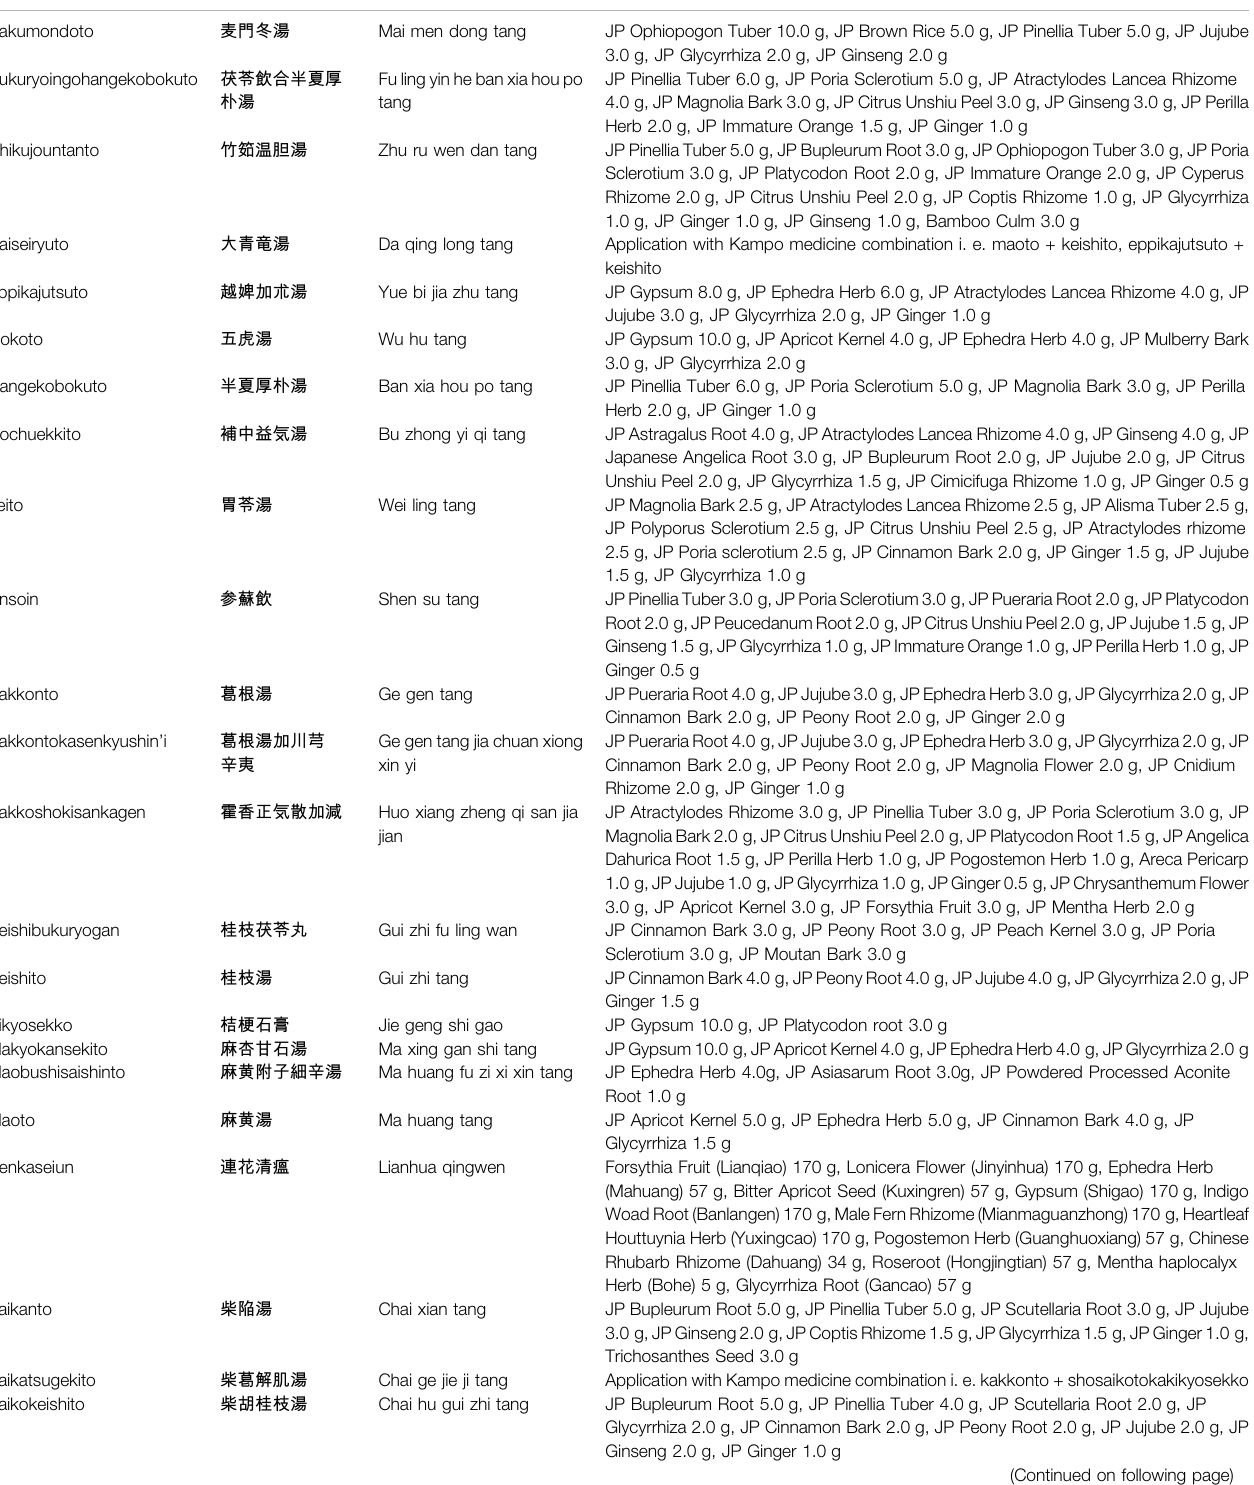
TABLE 2 | Kampo medicine and Chinese medicine described in the review of case reports. Japanese names in roman characters